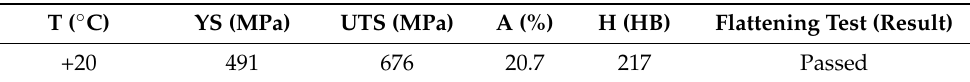
Table 4. Mechanical properties of the P92 tube